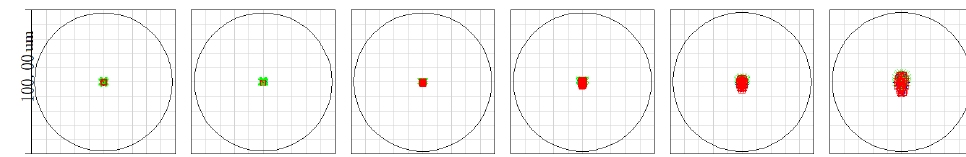
Figure 5. Light spots with the rotation angles 0°, 1°, 2°, 3°, 4°, 5°, the circles are the Airy disks.